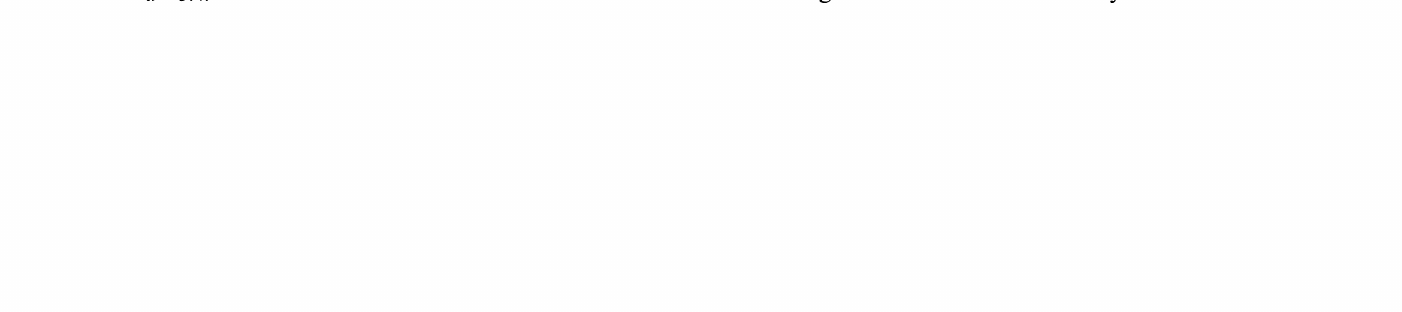
FIGURE 5 Transversal "size" of the bubbling attractor (max]xn-yn) in dependence on the value of the coupling. a--